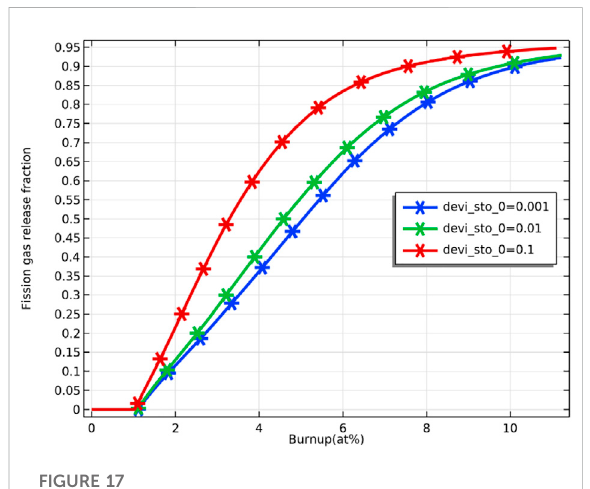
FIGURE 17 Variation of pellet inner surface fi ssion gas release rate with fuel burnup for deviation from the stoichiometry of oxygen of 0.001, 0.01 and 0.1.